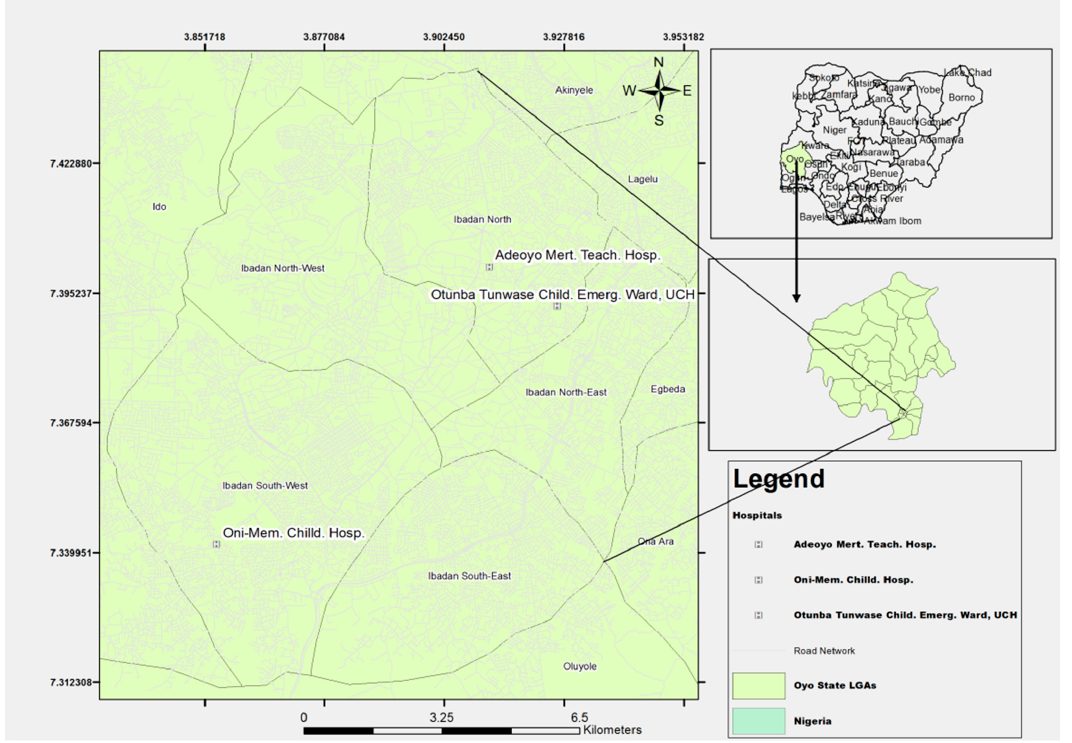
Figure 1. Map of Ibadan showing the location of participating hospitals. The figure was originally created for the purpose of the study.